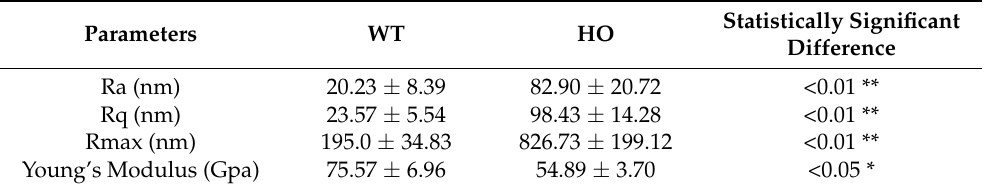
Table 1. The average surface roughness (Ra), root mean squared surface roughness (Rq), maximum surface roughness (Rmax) and Young’s modulus of the middle layer of the